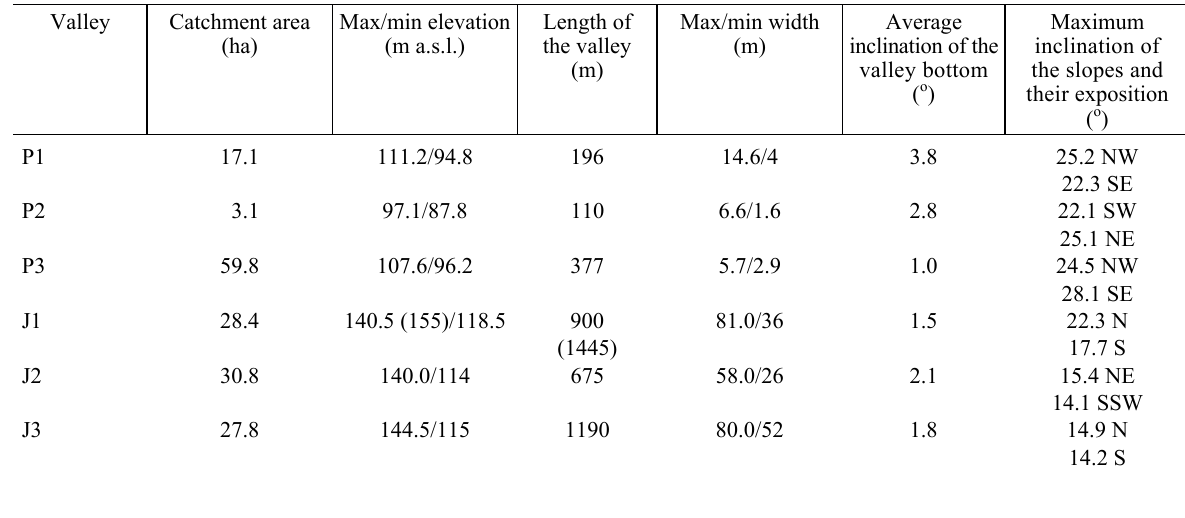
Table 1. Morphometric characteristics of the examined valleys